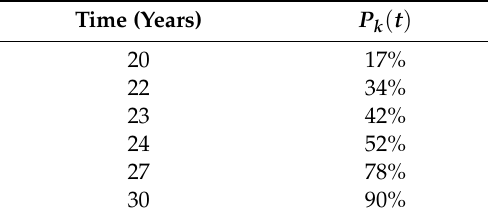
) with time (predictions at RSL